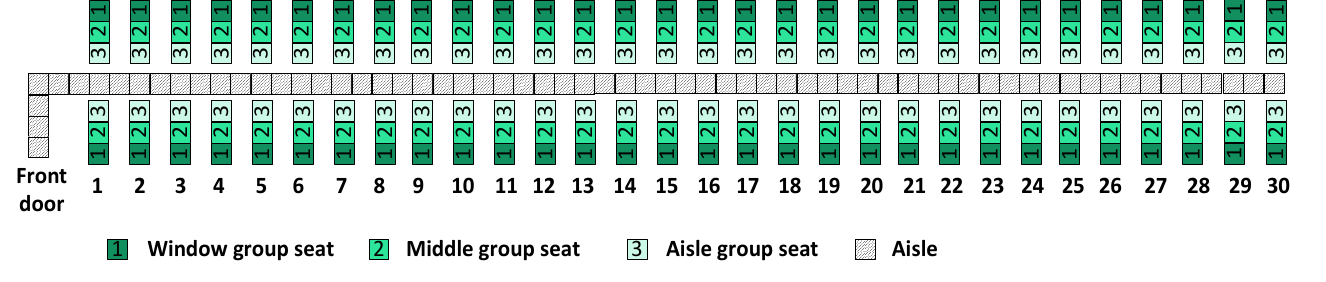
Figure 2. WilMA. Figure 2.